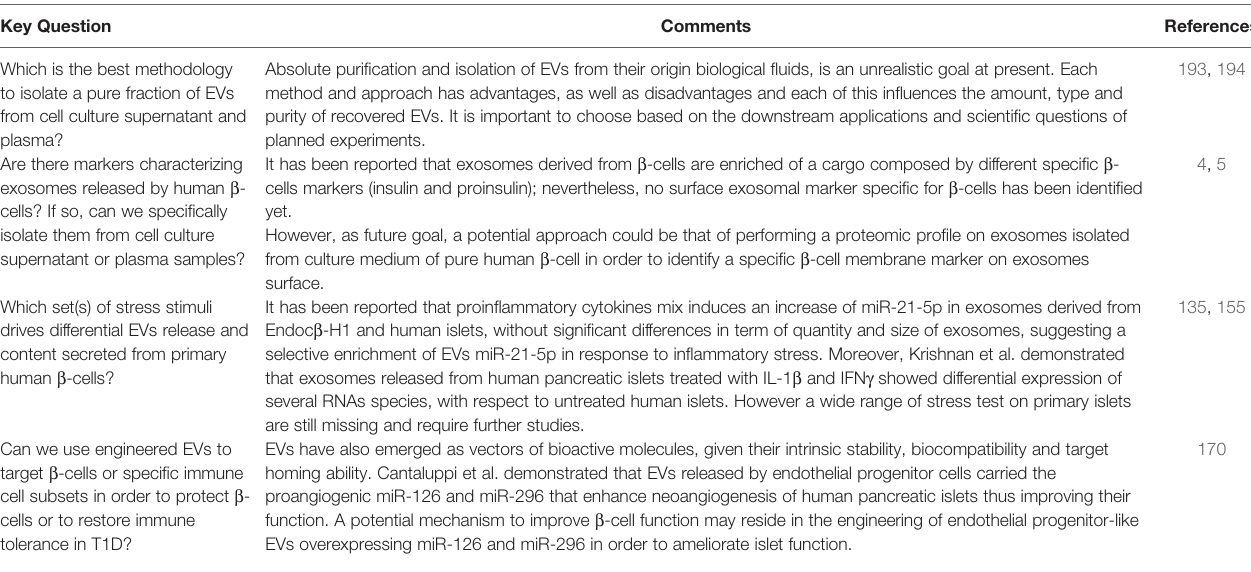
TABLE 3 | Outstanding questions on T1D and EVs: how to push the fi eld